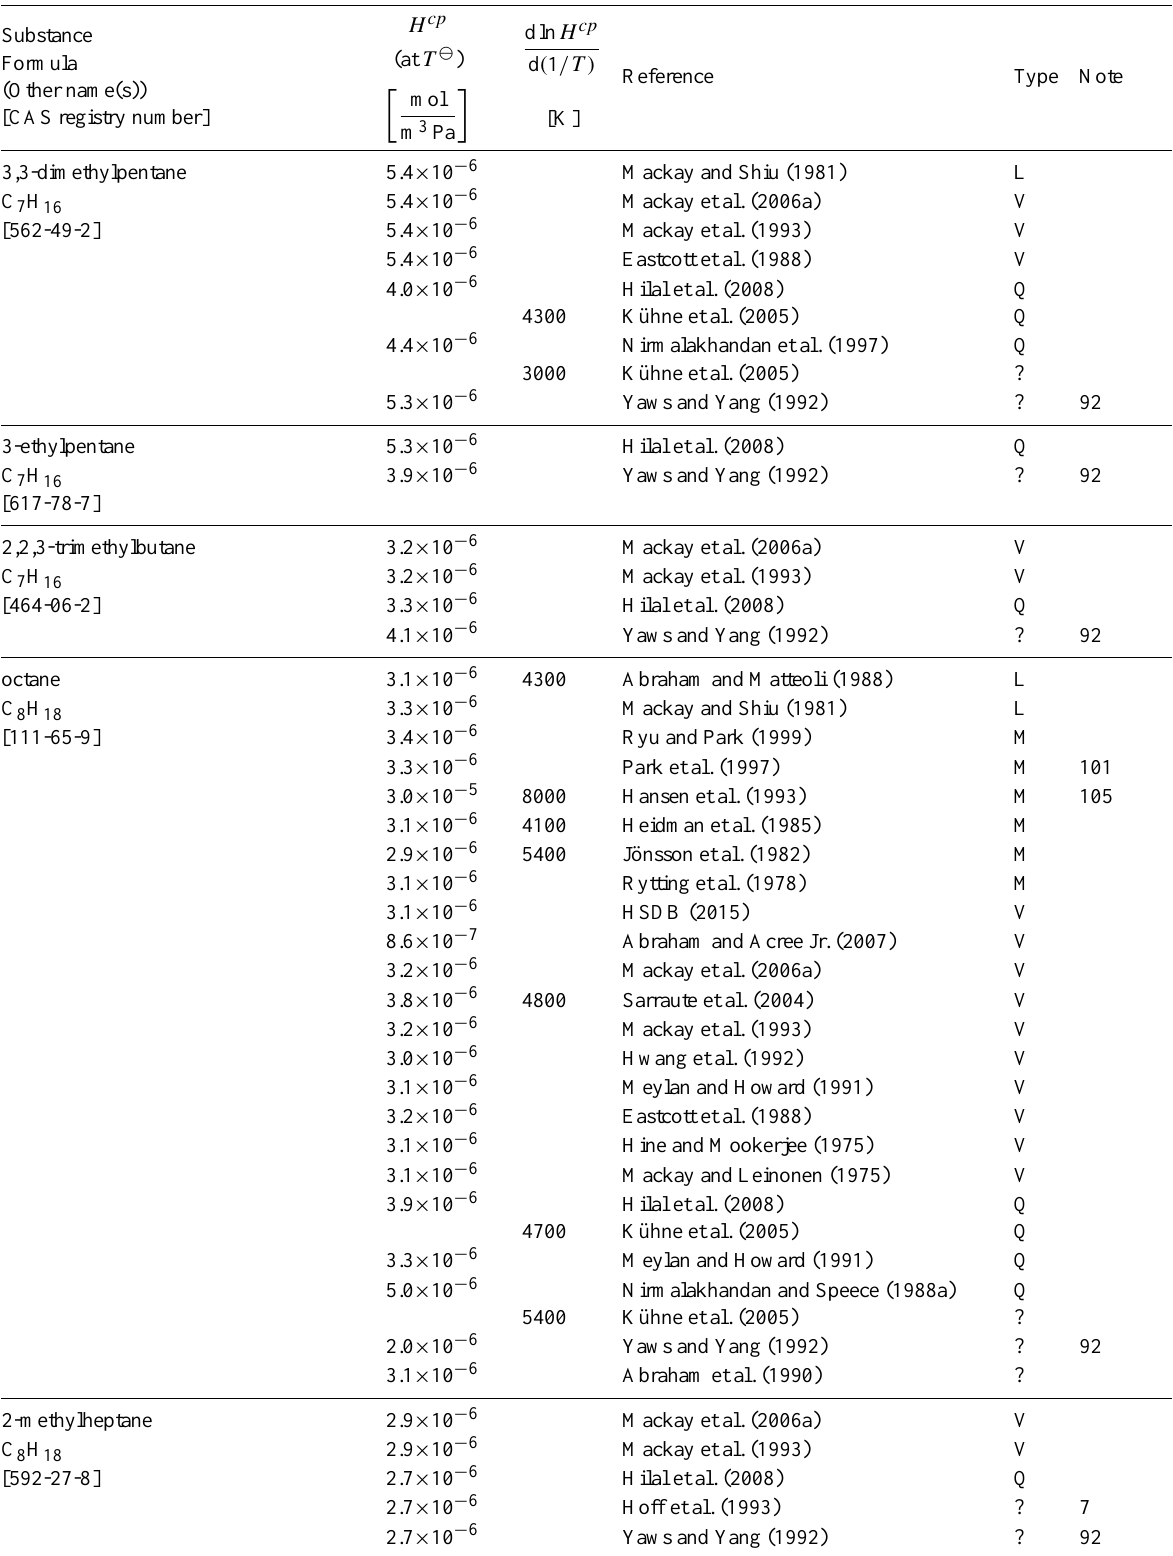
Table 6: Henry’s law constants for water as solvent